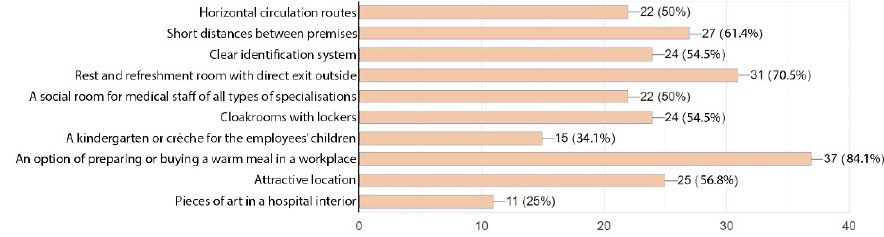
Figure 12. Spatial expectations of staff .